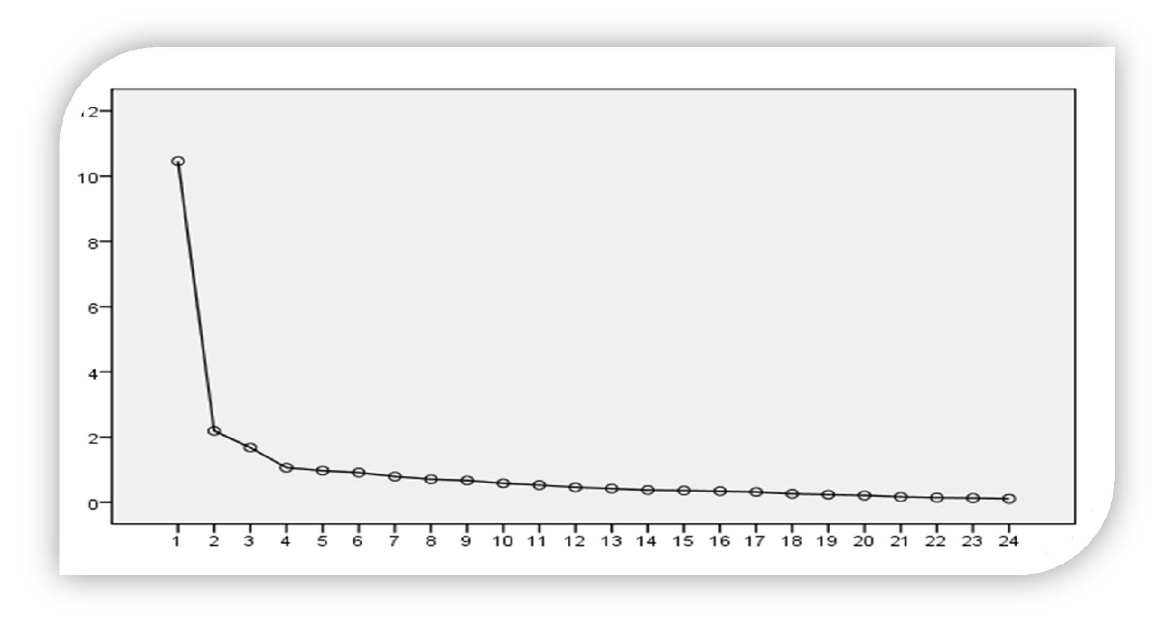
Fig. 1. The results of Scree plot